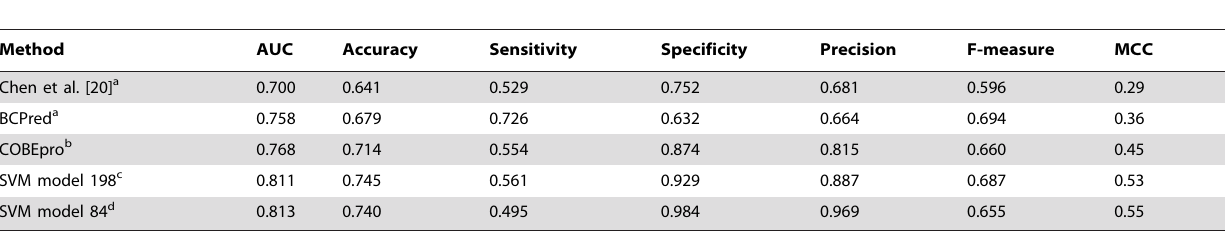
a results from Table 1 in [21]. b results from Table II in [22]. c results for the SVM model ( C =8.0 and gamma =0.000977) that uses all 198 features. d results for the SVM model ( C =1.0 and gamma =0.001953) that uses the selected 84 features.